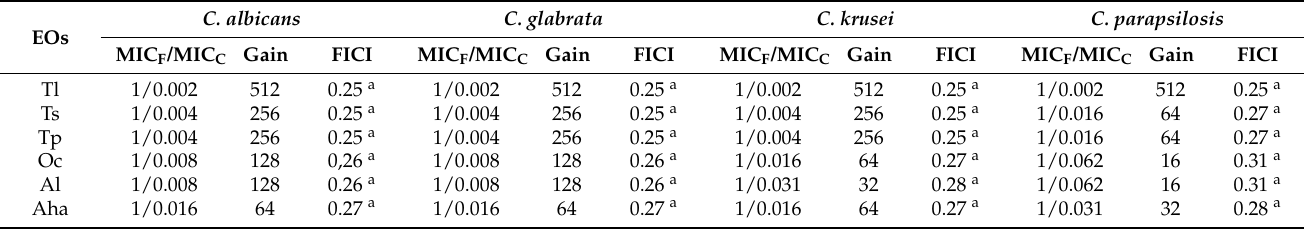
Table 4. Fractional inhibitory concentrations indices (FICIs) and gain of fluconazole combined with the essential oils. EOs